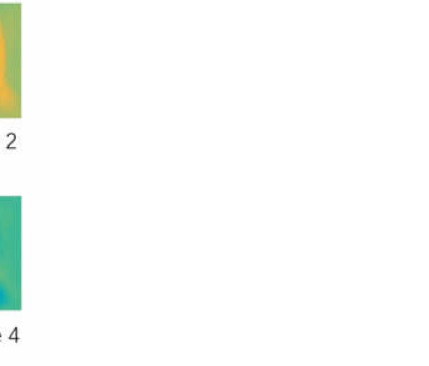
Figure 10. POD modes of vapor cavity structures at n = 910 r/min, Q = 0.031 m 3 /s, and dP = − 83 kPa.